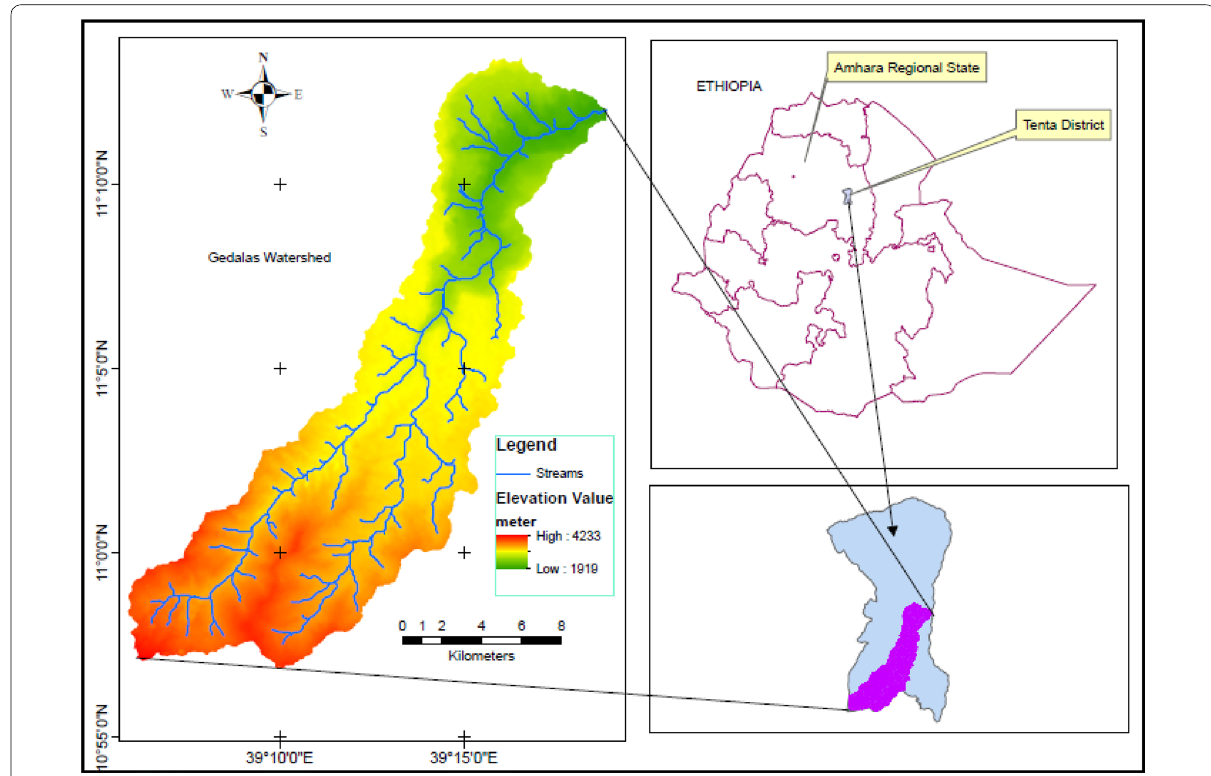
Fig. 1 Location of Gedalas Watershed in relation to Ethiopia and the Amhara